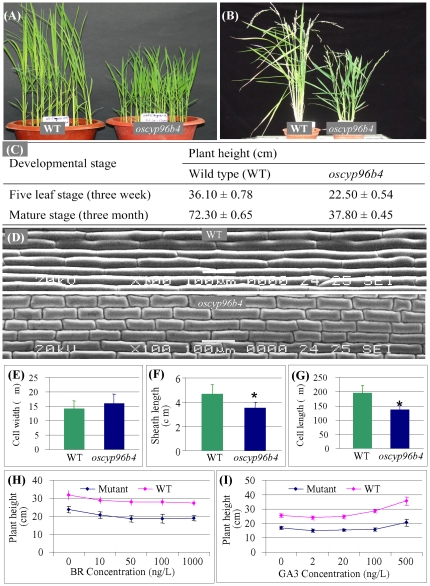
Phenotypic characterization of oscyp96B4 as a dwarf mutant.(A) and (B) Three-week old seedlings and mature plants of WT (left) and oscyp96b4 (right), respectively. (C) Detailed measurement of plant heights at both stages in WT (left) and oscyp96b4 (right). These stages include five-leaf stage (three week old) and mature stage (three month old). (D) Cryo-SEM images of 2nd leaf sheath surface of WT (top) and oscyp96b4 (bottom). Bars = 100 μm. (E) to (G) show the results from the investigation on cell width (E), sheath length (F) and cell length (G). (H) and (I) show the effect of BR (H) and GA3 (I) on the plant height in WT (blue) and oscyp96b4 (pink). Asterisks in (F) and (G) indicate significant differences between WT and the mutant plants at P<0.05 by t-test.